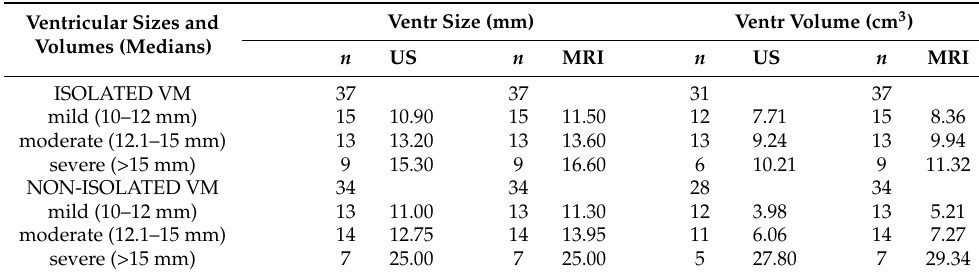
Table 1. US and MRI ventricular two-dimensional and volumetric median measurements. Abbrevia- tions: VENTR—ventricular.